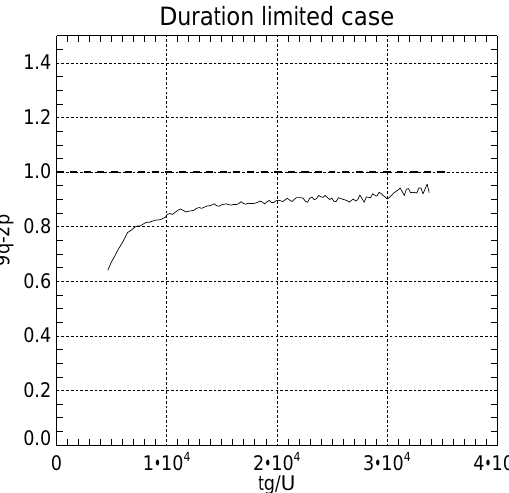
Figure 4. Dimensionless mean frequency (cid:104) f (cid:105)· U/g = E/N · U/g (solid line) vs. dimensionless time tg/U for the wind speed U = 10ms − 1 duration limited case – solid line, self-similar solution with the empirical coefficient in front of it: 16 . 0 · (tg/U) − 3 / 7 – dashed line.